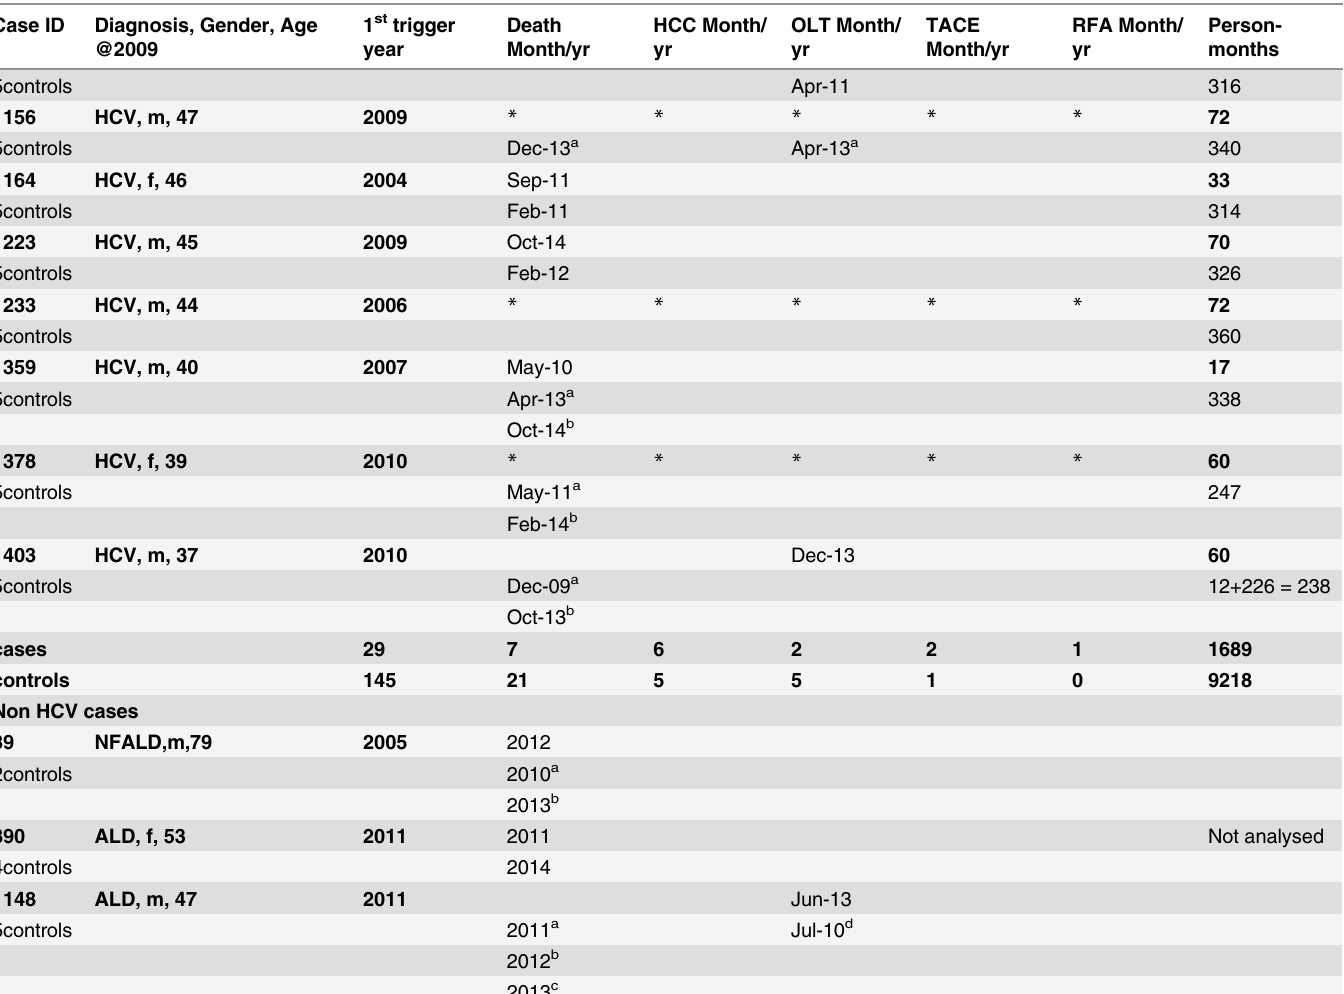
the algorithm detected ‘ high risk ’ HCC behaviour during screening prior to HCC development, the AFP did not change clinical management and the HCC was detected incidentally by cross sectional imaging performed for decompensated liver disease (jaundice and ascites). In both cases an US was performed within 6 months of HCC diagnosis and detected no clinically sig- nificant lesion. Of these two patients, one was dead within a year and received no